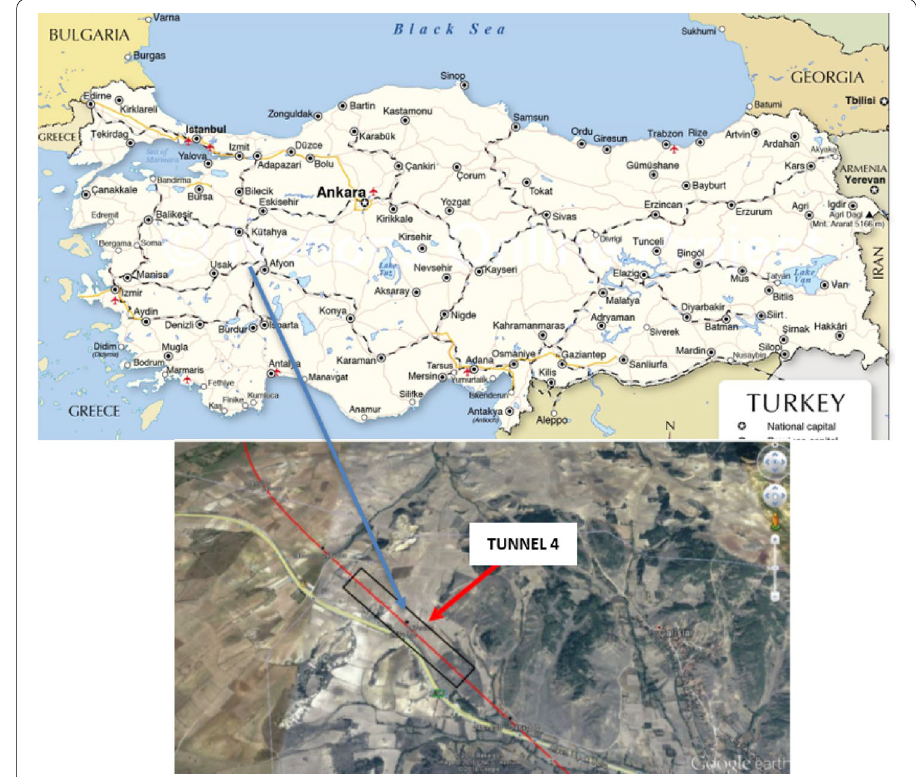
Fig. 1 Map of the location of the T4